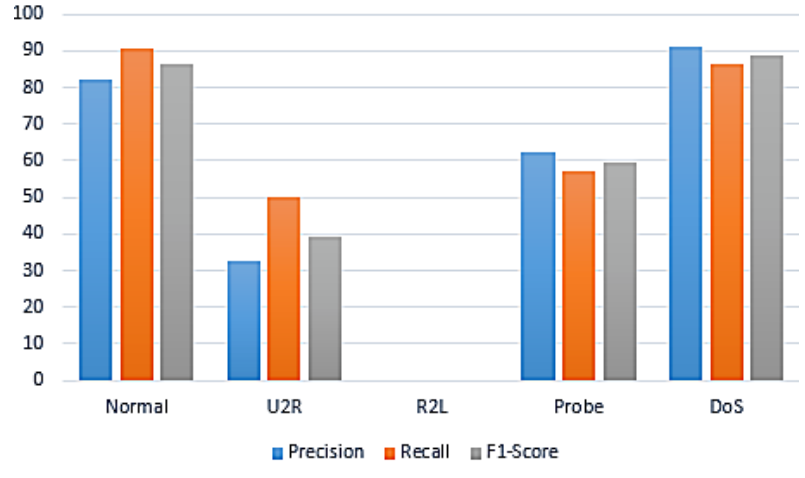
Figure 10. Classification report of Naive Bayes.